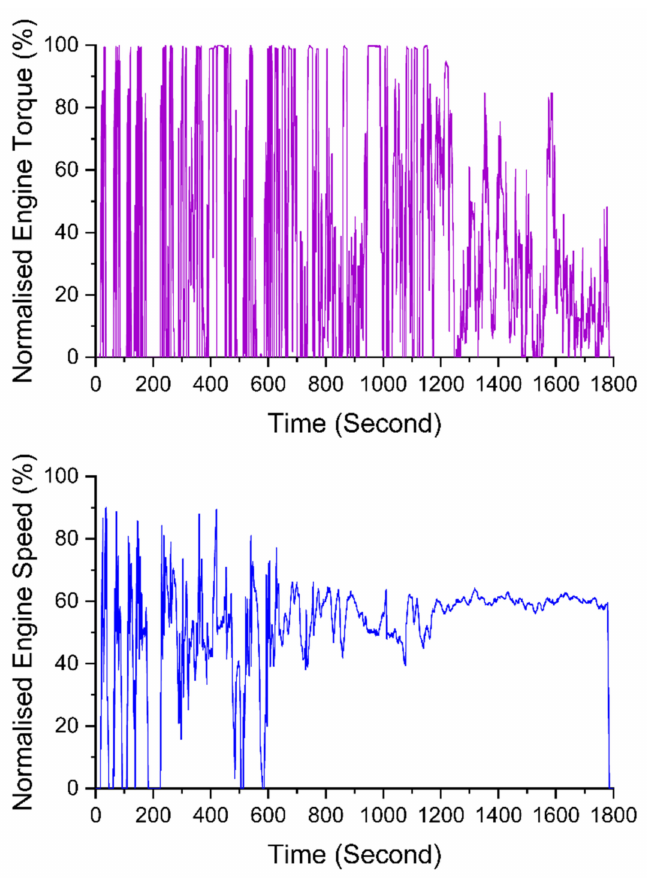
Figure 13. The European Transient Cycle (ETC) for heavy-duty